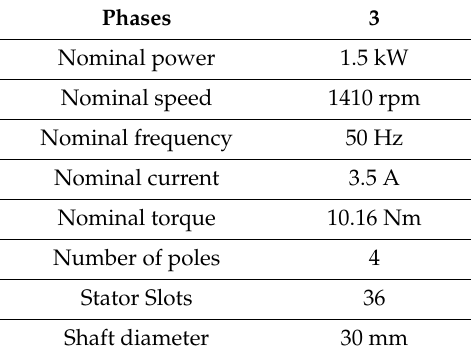
Table 1. Parameters of the induction motor (IM), which the permanent magnet synchronous generator (PMSG) is based on.